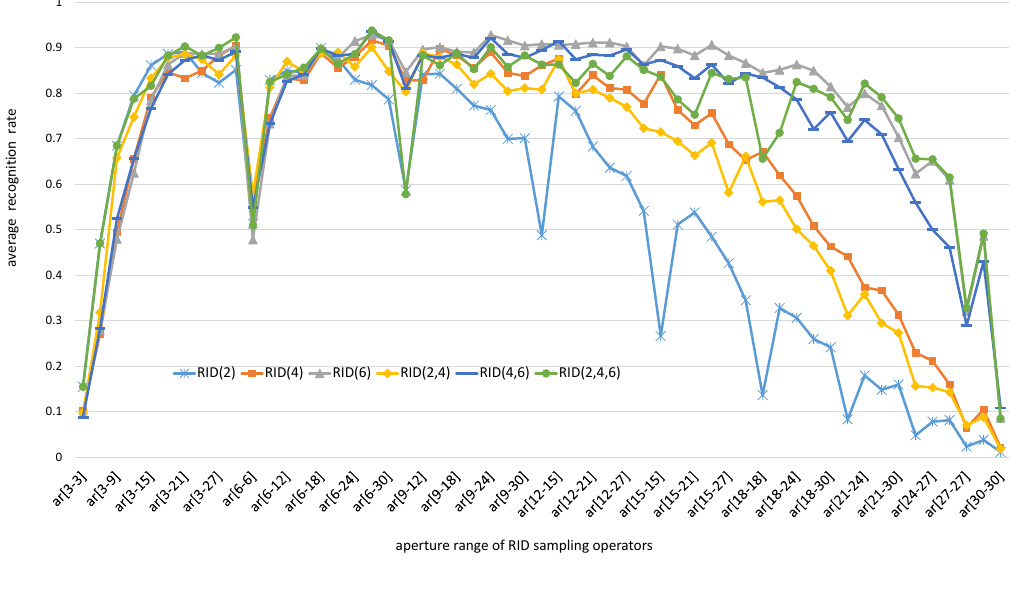
Figure 7. Each recognition rate curve is averaged across all images in Figure 4a. Each curve reflects the change of the recognition rate of RandomFerns classifier with the change of RID operator aperture. These experimental curves are obtained from gray images and the channels of sampling cells within each RID operator are the